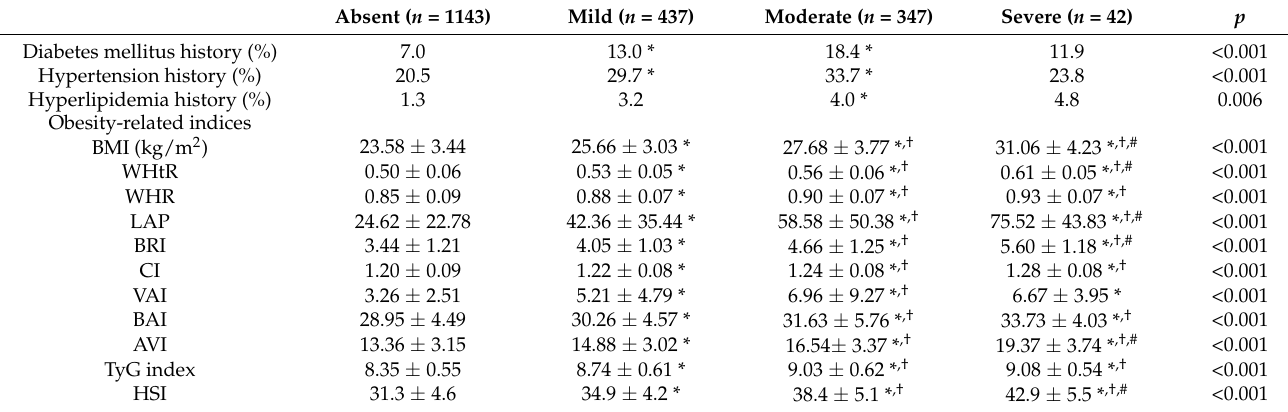
Table 4. Comorbidity and the values of obesity-related indices according to the severity of NAFLD in study participants.